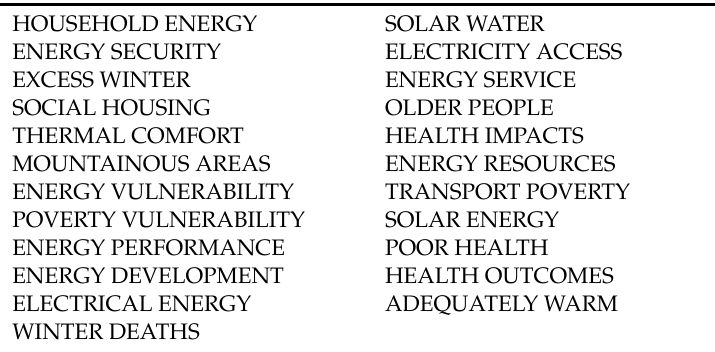
Table A8. Most important two word phrases.